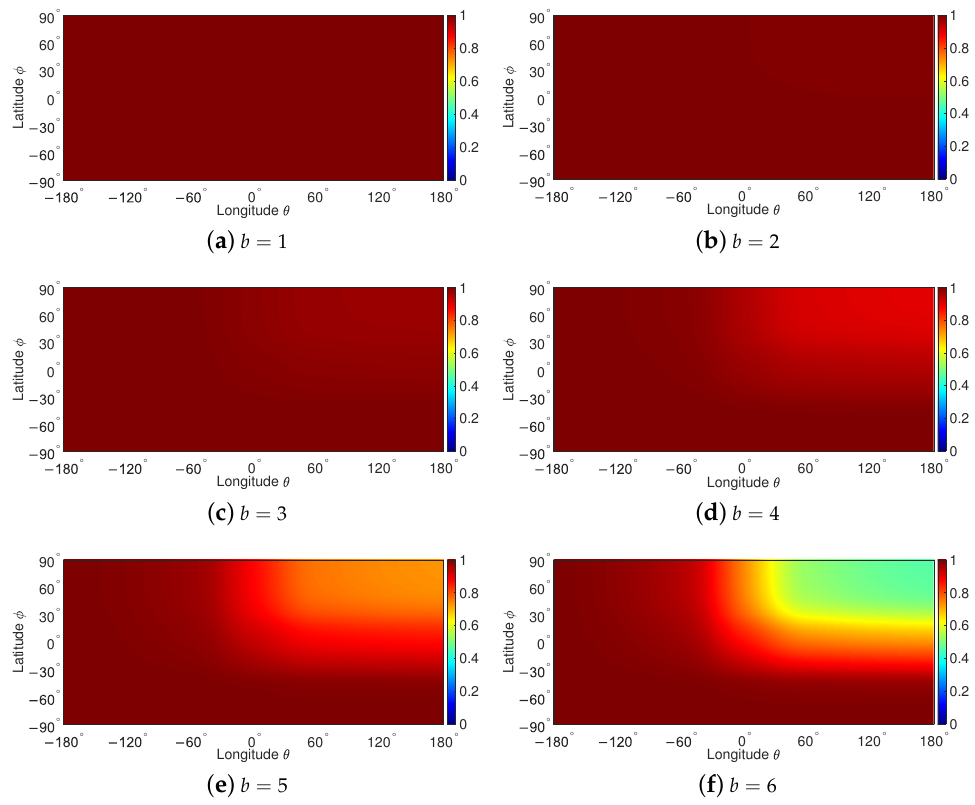
Figure 21. NCP-SSIM( φ , θ ) of viewing direction based LSB data hiding in the latitude and longitude of 360 ◦ cover video “Salon” for different number of bit